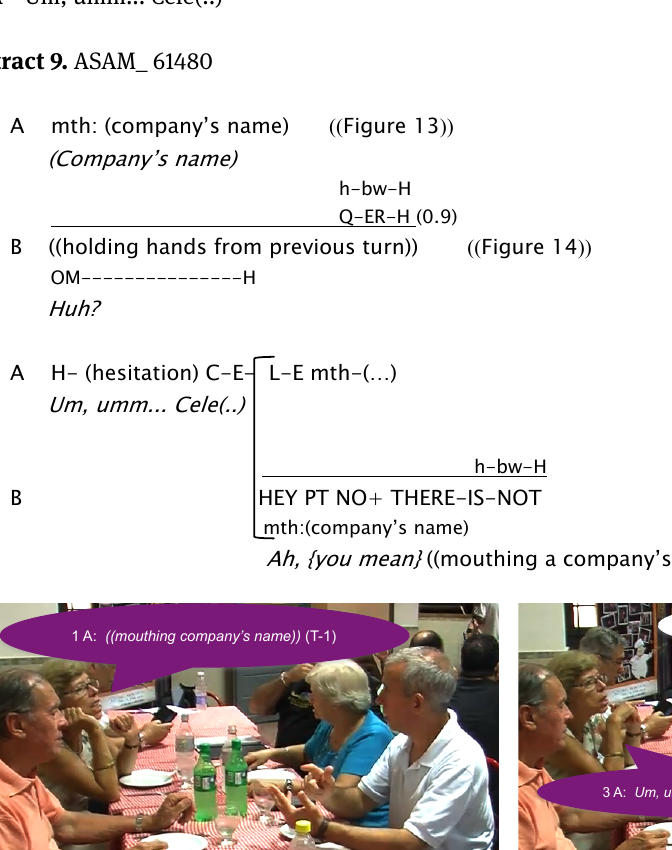
Figure 13. ( ‘Company’s name’ ), Person A, on the left side of the arrow, mouths the name of a company to Person B, on the right of the arrow, line 1 (T-1).